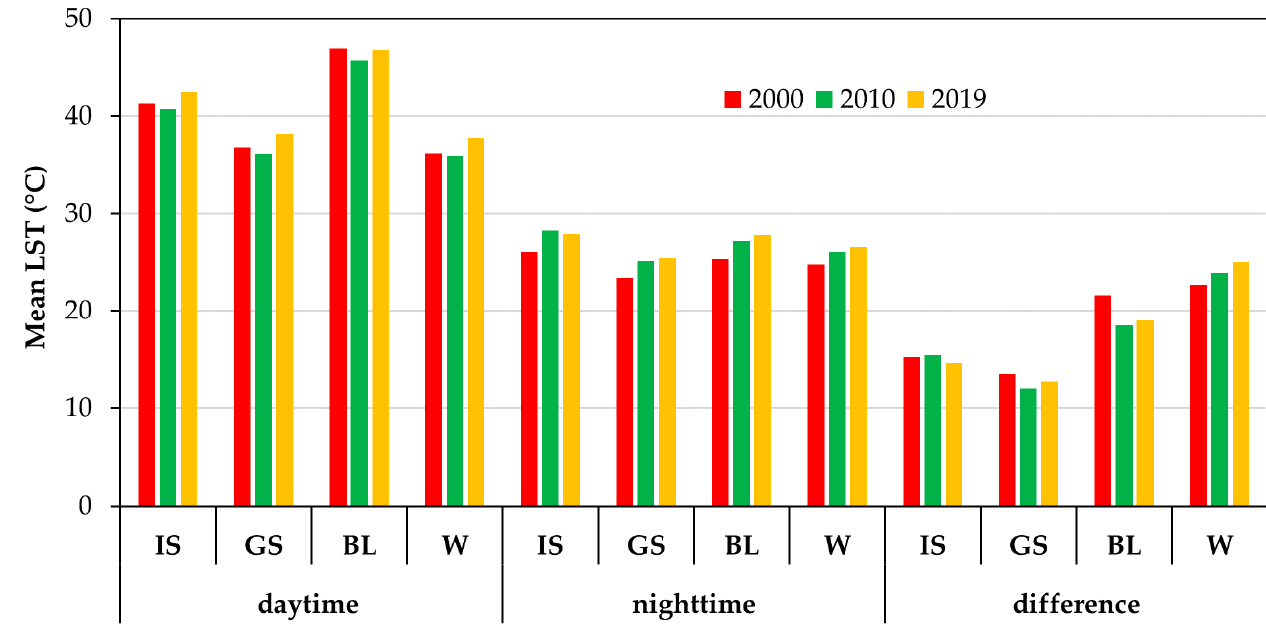
Figure 5. Mean LST of the LUC types in Greater Cairo, Egypt, in 2000, 2010, and 2019. Note: IS = Impervious surface; GS = Greenspace; BL = Bare land; and W = Water.